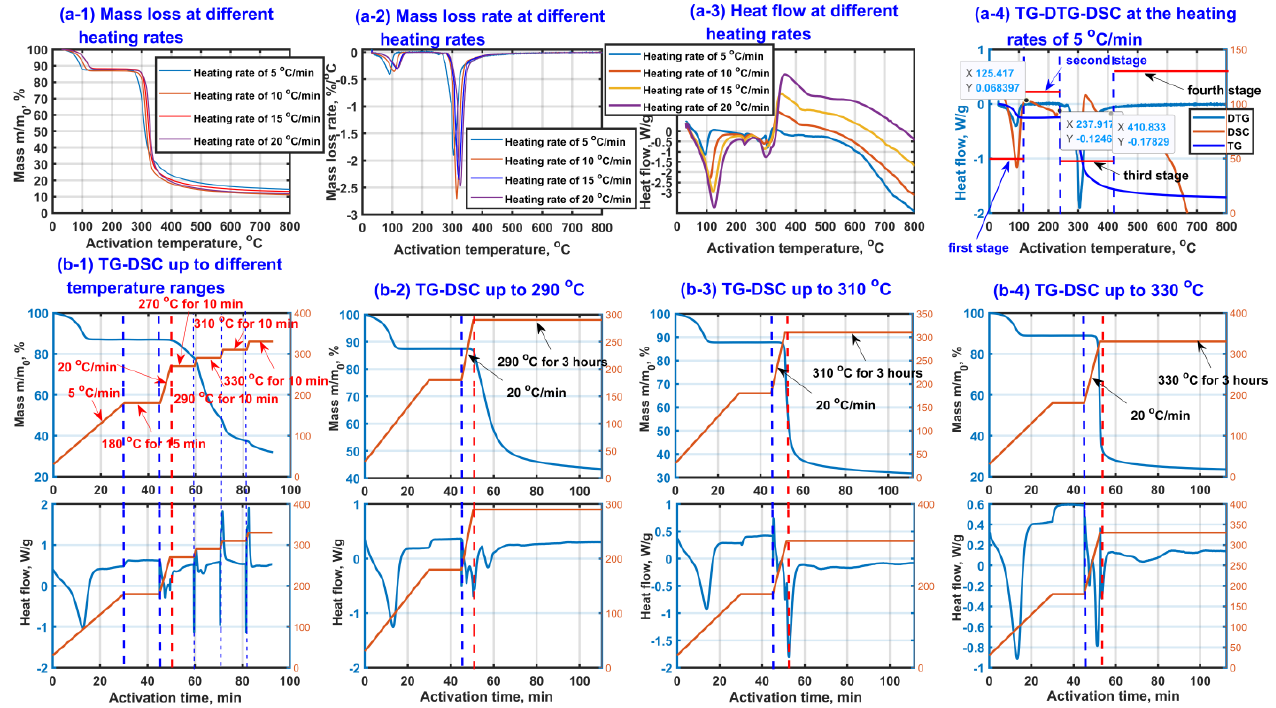
Figure 1. Thermal activation of β -CD samples at different heating conditions (TG curve diagram ( a-1 ), DTG curves ( a-2 ), DSC curves ( a-3 ), TG-DTG-DSC at heating rate of 5 °C/min ( a-4 )) and TG-DSC graphs (heated to 180 °C with a heating rate of 5 °C/min and kept for 15 min, then heated to different temperatures ( b-1 ), 290 °C ( b-2 ), 310 °C ( b-3 ) and 330 °C ( b-4 ) with the heating rate of 20 °C/min and kept for 3 h).